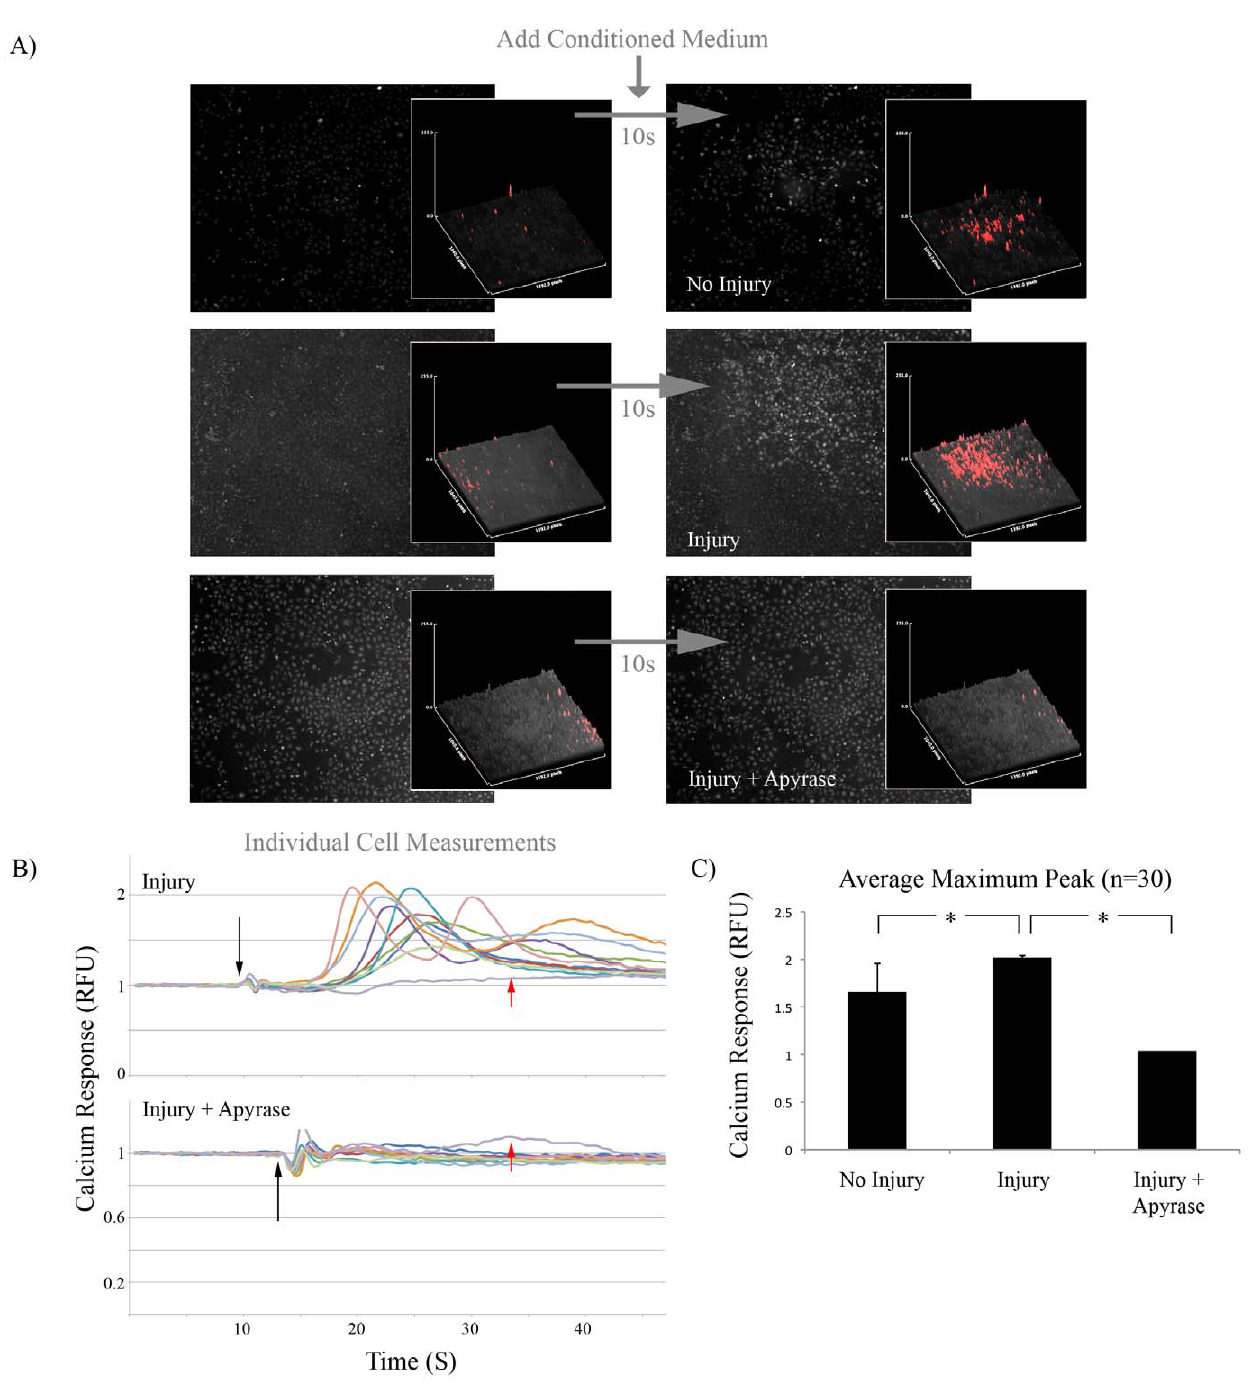
Figure 3. Trinucleotides from Injured Cells Were Required to Initiate Calcium Response. A) Conditioned medium from viable (No Injury), mechanically disrupted (Injury) or mechanically disrupted lysate treated with 250 mU/mL apyrase for 10 min. (Injury + Apyrase) was placed on a confluent layer of Fluo-4 labeled A549 cells. Left column: Before addition of conditioned medium. Right column: 10 s after treatment with conditioned medium. Magnification = 4 6 . Inset for each: Pixel intensity profile for entire field of view. Inset images for each treatment group were manipulated equally using the threshold function in Adobe Photoshop in order to false color the peaks for clarity (red). n = 3 movies. B) Calcium response of 10 individual cells following addition of Injury or Injury + Apyrase (250 mU/mL for 10 min) treated conditioned medium. Black Arrow: Addition of conditioned medium. Red Arrow: Background Intensity Measurement. C) Average maximum intensity for individual cells after addition of No Injury, Injury, or Injury + Apyrase conditioned medium. * = p , 0.05; n = 30.